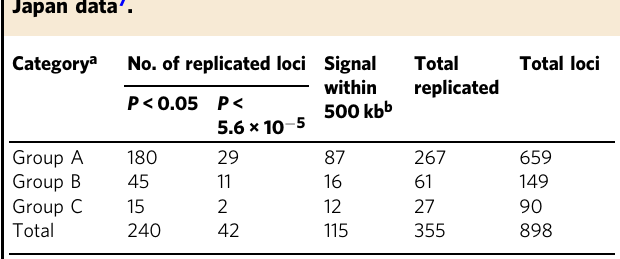
Table 2 Summary of replicated loci compared to Biobank Japan data 7 .